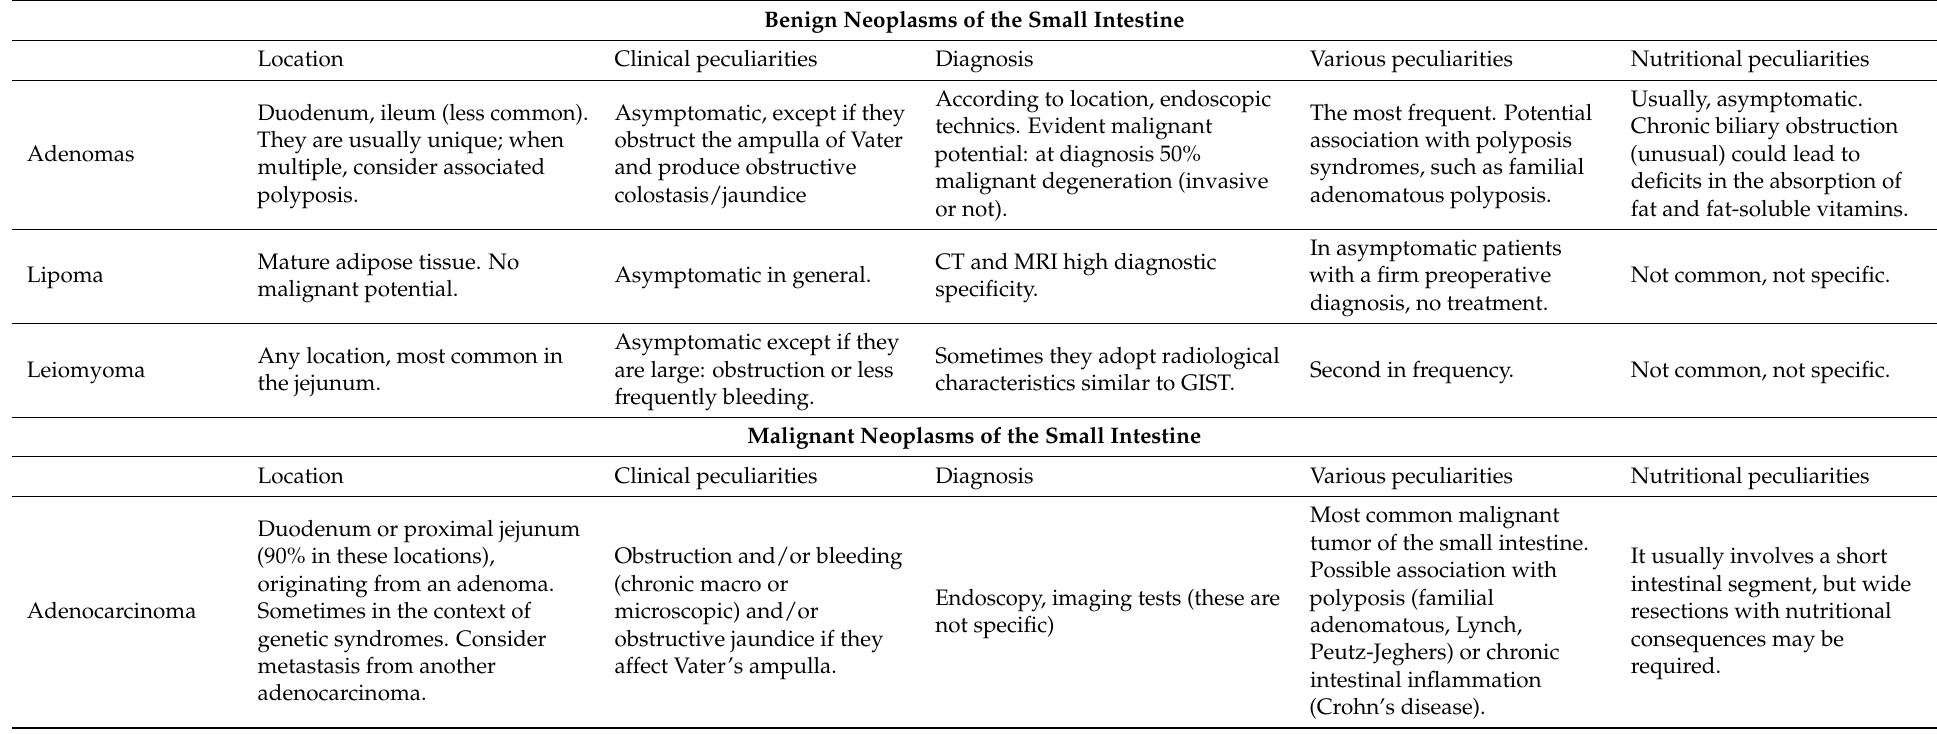
Table 8. Relevant clinical, diagnostic, and nutritional features of small bowel